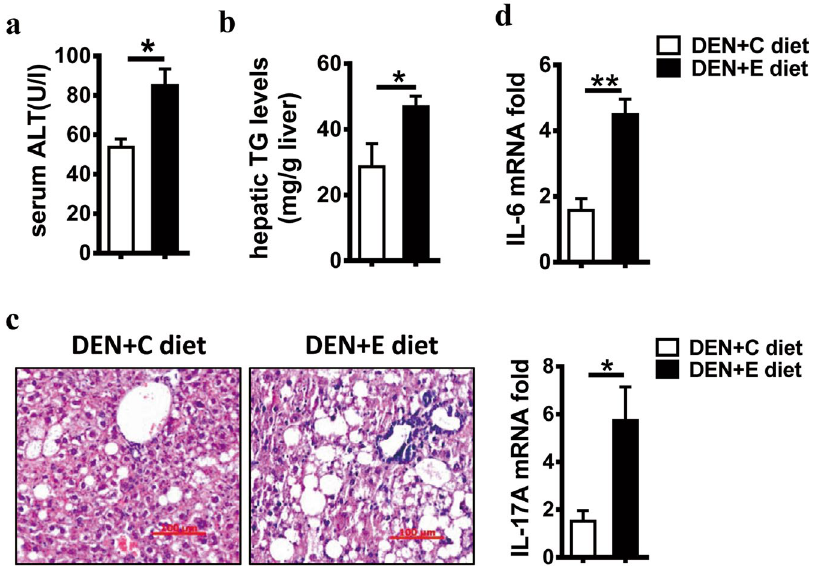
Figure 4. Alcohol consumption enhances the level of inflammation in DEN-initiated hepatocarcinogenesis. Liver injury and steatosis in DEN + C diet and DEN + E diet mice were evaluated by ( a ) serum alanine aminotransferase (ALT) levels and ( b ) hepatic triglyceride (TG) levels as well as ( c ) hematoxylin and eosin staining (H&E) (original magnification, 200 × . Scale bar, 100 μ m) and ( d ) relative mRNA expression of IL-6, IL- 17A in livers, as determined by Q-PCR. Data are shown as the means ± SEM (n = 3–4 for DEN + C diet, n = 4–6 for DEN + E diet). * P < 0.05. ** P < 0.01.